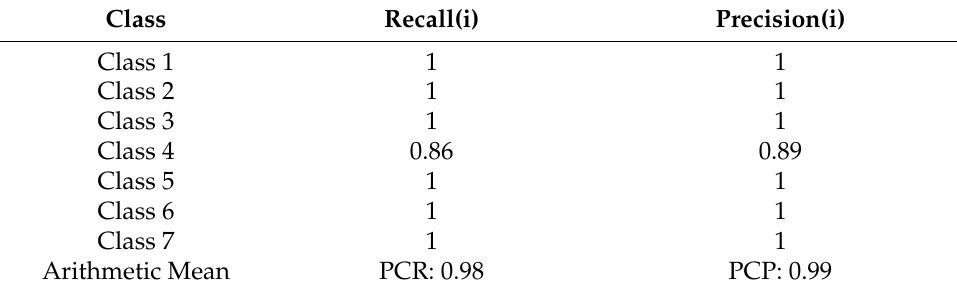
Table 7. PCR and PCP for the proposed model.